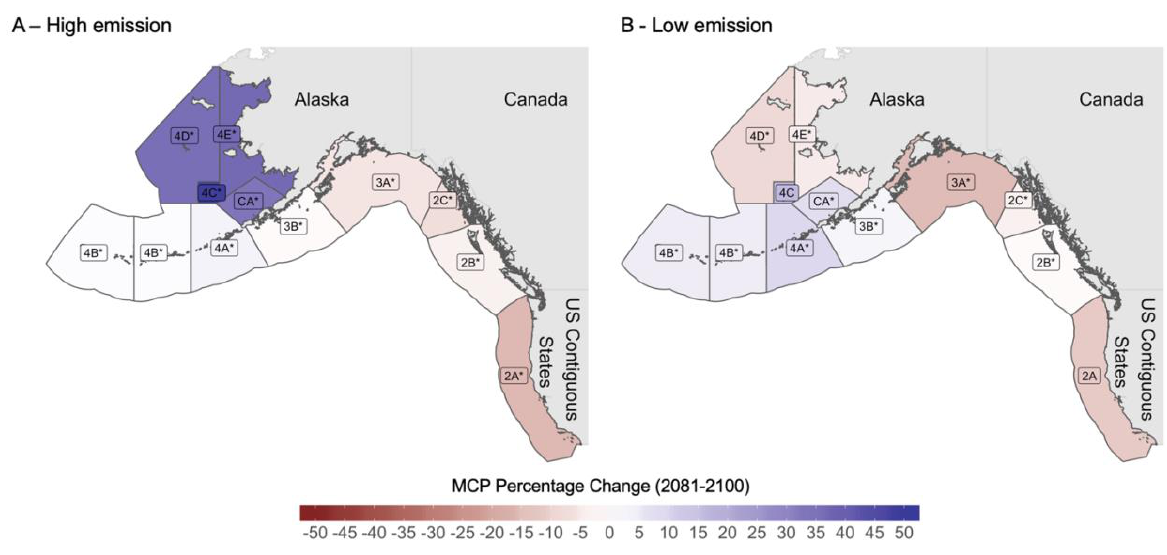
Fig. A1.1. Percentage change of MCP for species managed by the IPHC for end-century (2081– 2100) relative to 2005–2014 under a (A) high emission scenario and (B) low emission scenario. Labels marked with "*" represent regions where models do not agree in direction of